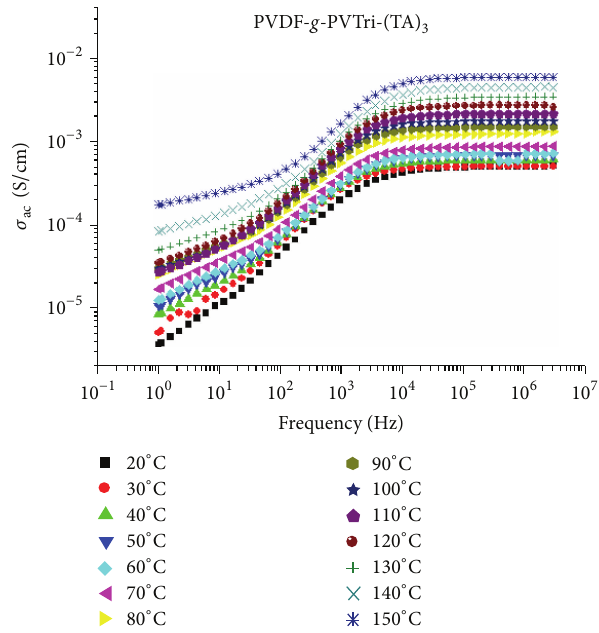
Figure 7: AC conductivity versus frequency of PVDF- g -PVTri- (TA) 3 at several